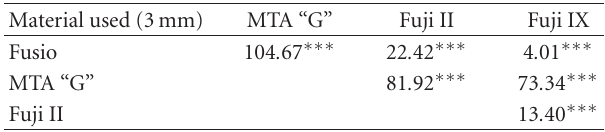
Table 2: Results of t -test for independent samples between each two materials at 2 mm depth.